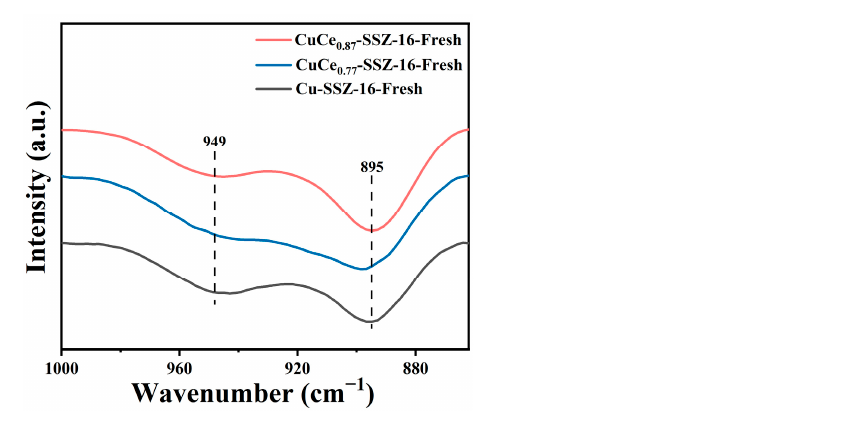
Figure 10. In situ DRIFTS spectra of Cu-SSZ-16-Fresh, CuCe 0.77 -SSZ-16-Fresh, and CuCe 0.87 -SSZ-16-